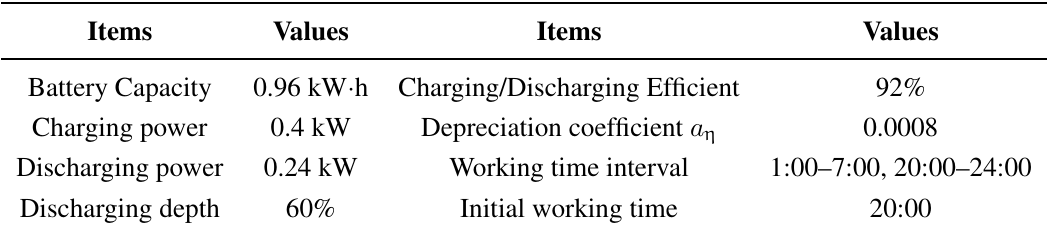
Table 4. Parameters for battery of household plug-in electric bicycle: battery is assumed to be charged right at the initial time for the case without energy consumption scheduling function deployment; for the case with energy consumption scheduling function deployment, the timing for the operation of each shiftable appliance is determined by game result; the discharging power level, discharging time interval, and depreciation coefficient is only valid with energy consumption scheduling and discharging